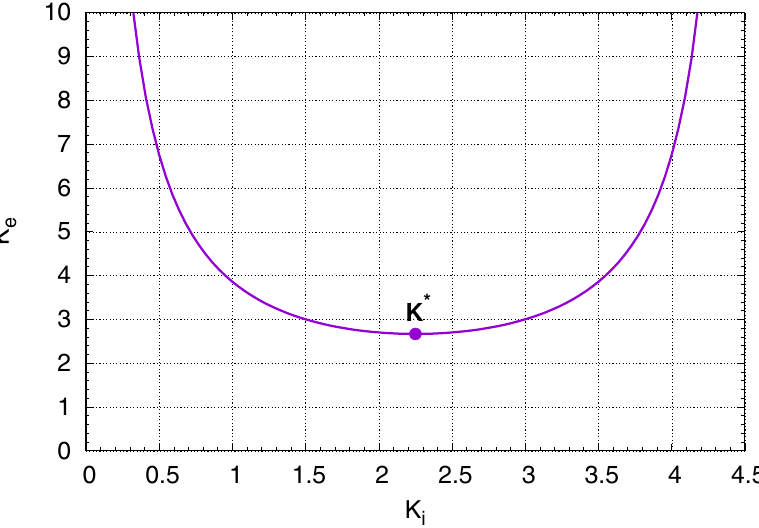
Figure 2. Plot of K e versus K i for making the same exponential decay in the time response to a step input. The optimum bias point is for K (cid:63) = ( 9/4,8/3 ) .